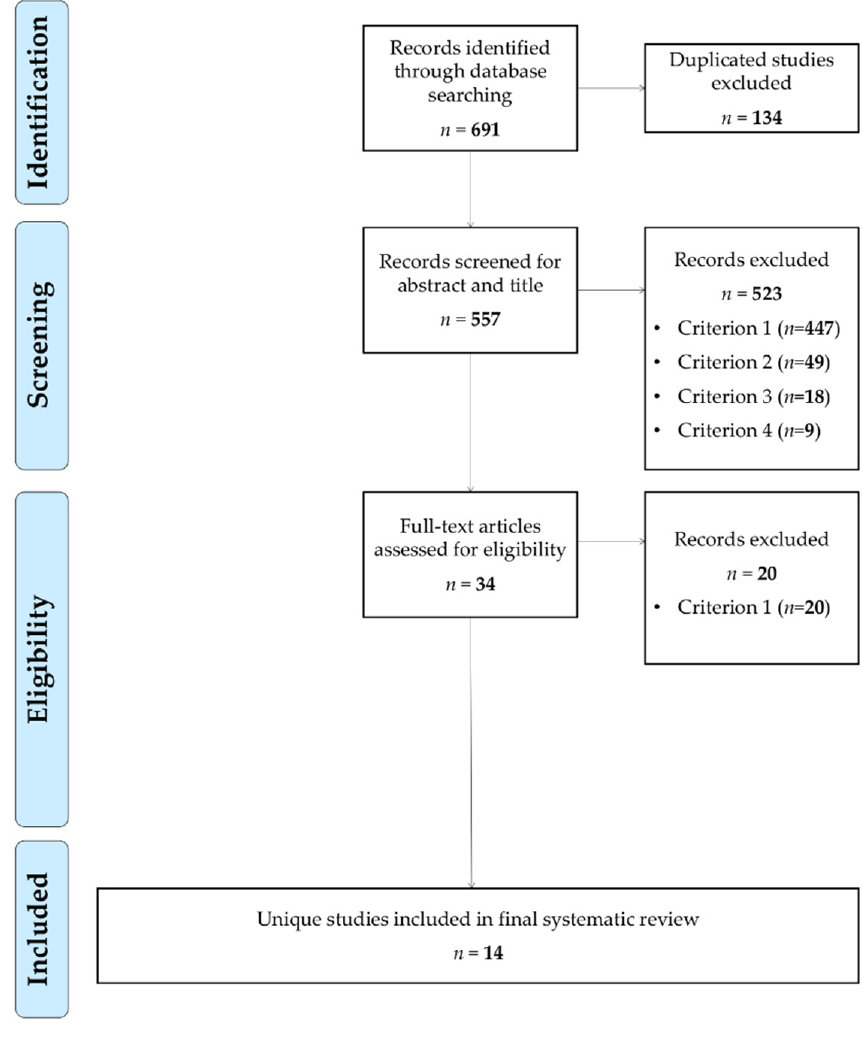
Figure 1. PRISMA flowchart .